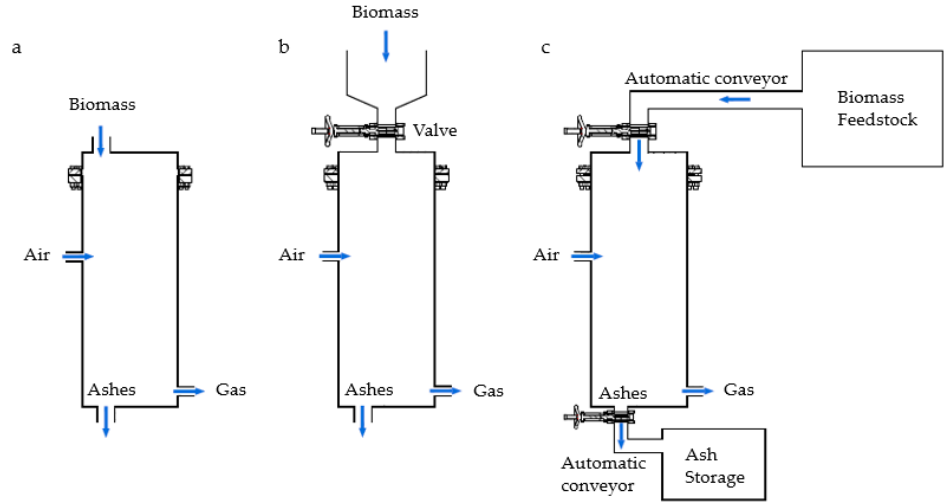
Figure 3. Representation of the three modes of biomass feeding ( a ) batch; ( b ) semi batch and ( c ) continuous.